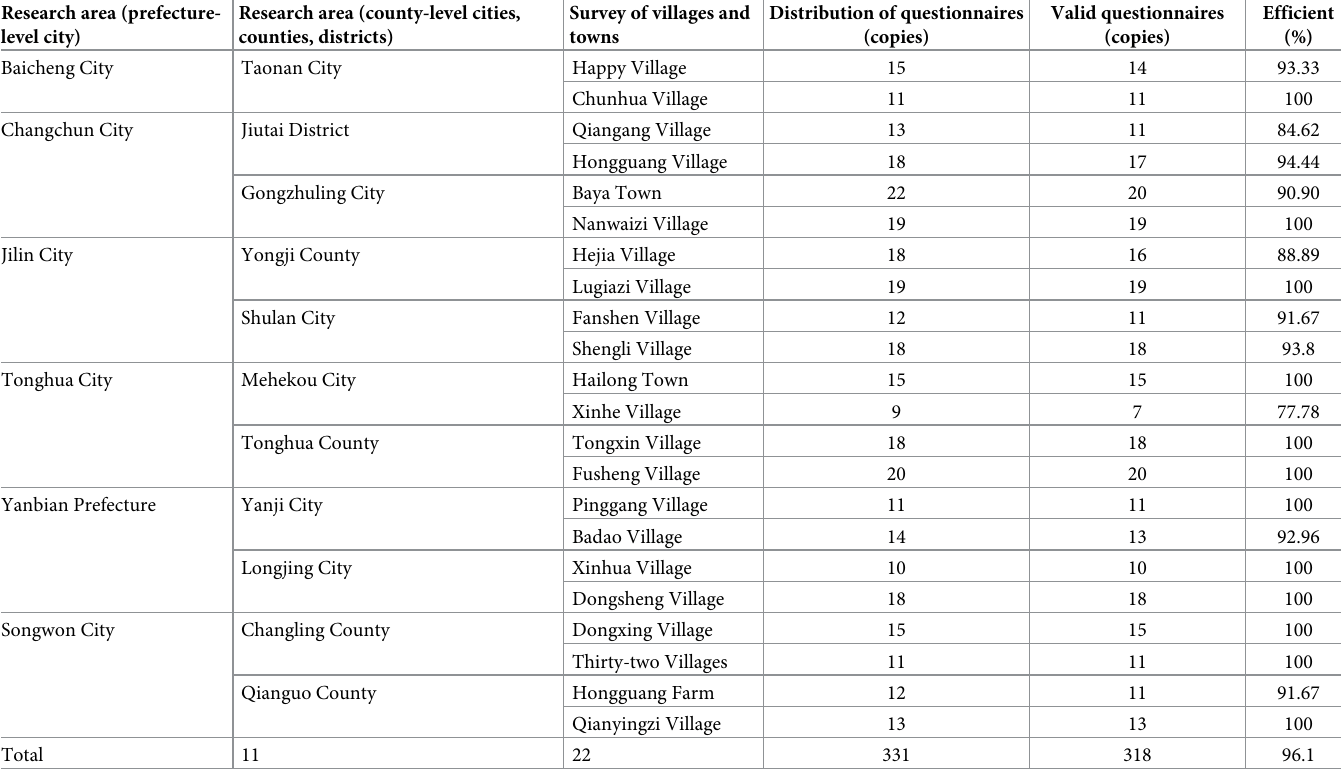
Table 1. Overview of the sources of survey